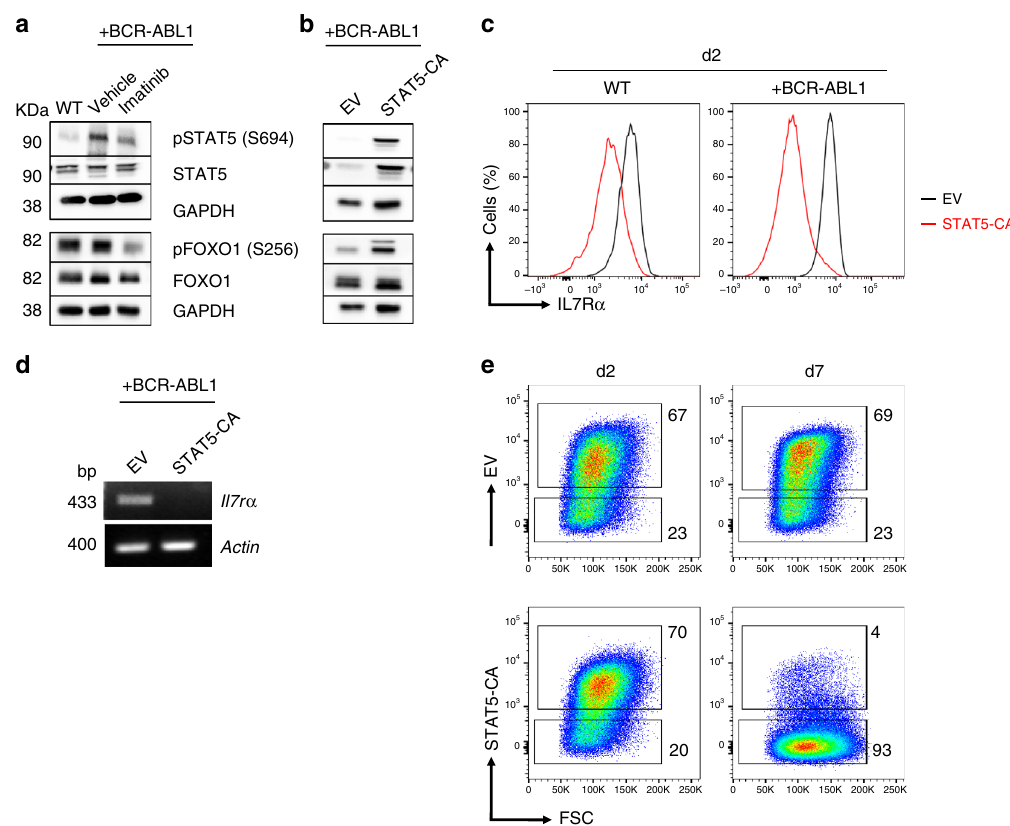
Fig. 5 Negative feedback regulating BCR-ABL1-induced transformation. a Western blot analysis for increased phosphorylation of STAT5 and FOXO1 by BCR-ABL1 activity. b Western blot analysis showing that constitutively active STAT5 (STAT5-CA) enhances FOXO1 phosphorylation. The western blot results in a and b are representative of three independent experiments; KDa kilo Dalton. c Ectopic expression of STAT5-CA in WT pre-B cells (left) or BCR- ABL1-transformed cells (right) leads to downregulation of surface expression of IL7R protein after 2 days of transduction. d Reverse transcriptase PCR analysis showing downregulation of IL7R due to constitutive activity of STAT5; actin was used as a loading control. cDNA was prepared from sorted cells after 2 days of transduction. bp base pair. e Loss of BCR-ABL1-transformed pre-B cells which overexpress constitutively active STAT5 (STAT5-CA). Representative fl ow cytometry plots at day 2 and 7 after transduction. EV empty vector. a – e The results are representative of three independent